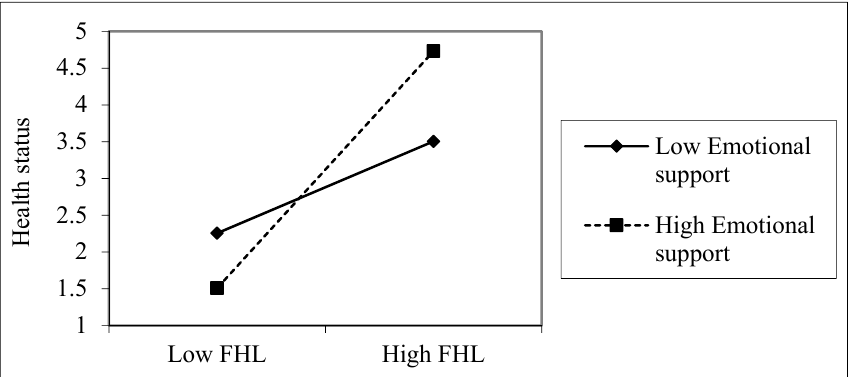
Figure 1. The association between emotional support, FHL, and health status among younger adults. Health status was measured on a five-point scale (poor, fair, good, very good, and excellent). The values used in the plotting are based on the unstandardized regression coefficients.